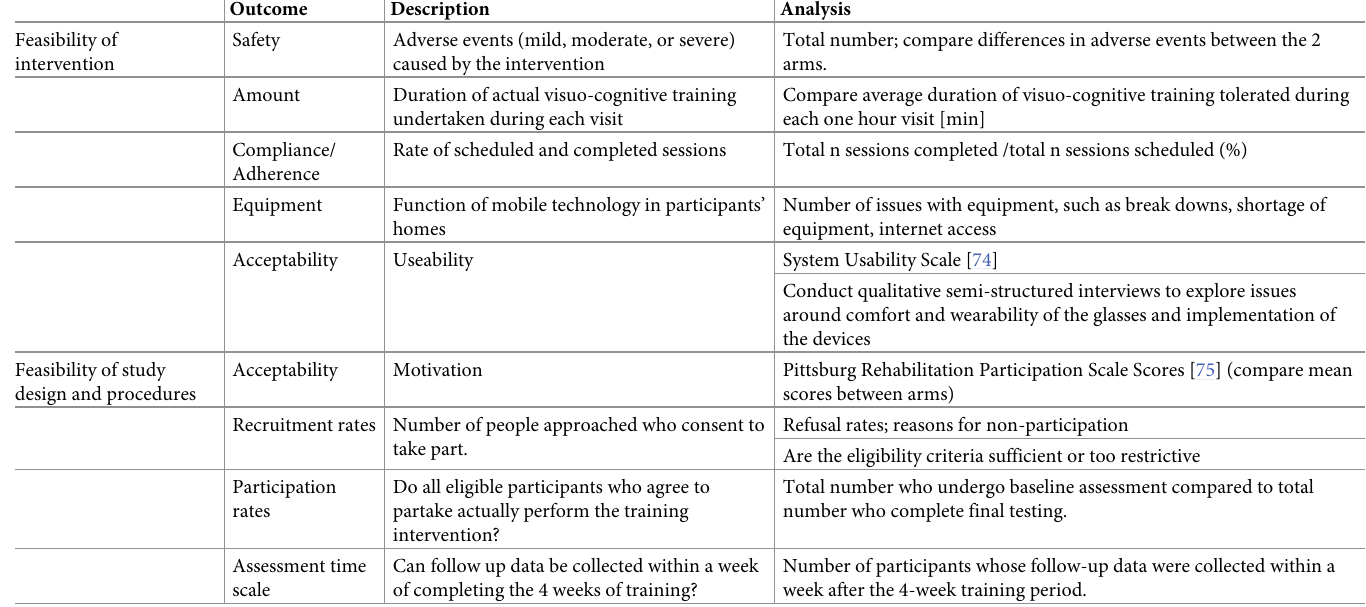
Table 1. Feasibility